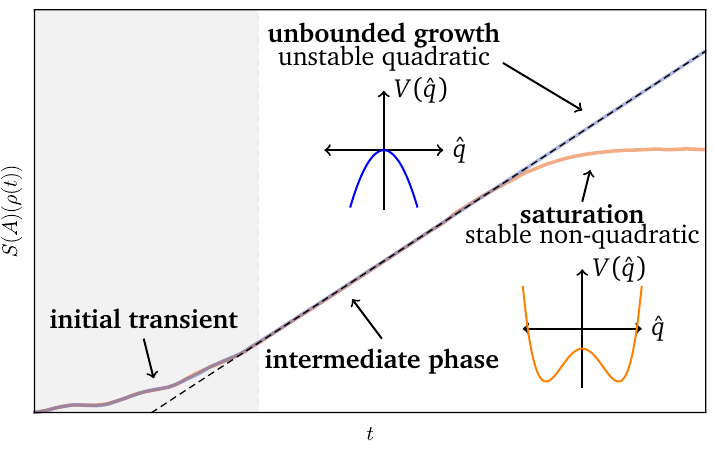
Figure 4: Illustration: physical Hamiltonians vs. their quadratic approximation. While an unstable quadratic Hamiltonian leading to unbounded linear growth of the entan- glement entropy (in blue) is unphysical, we can still use the predicted linear growth the for intermediate growth phase of a stable non-quadratic Hamiltonian (in orange). We schematically indicate the respective potential V ( ˆ q ) of a single bosonic mode with ˆ p 2 + V ( ˆ q ) Hamiltonian ˆ H = 1 2